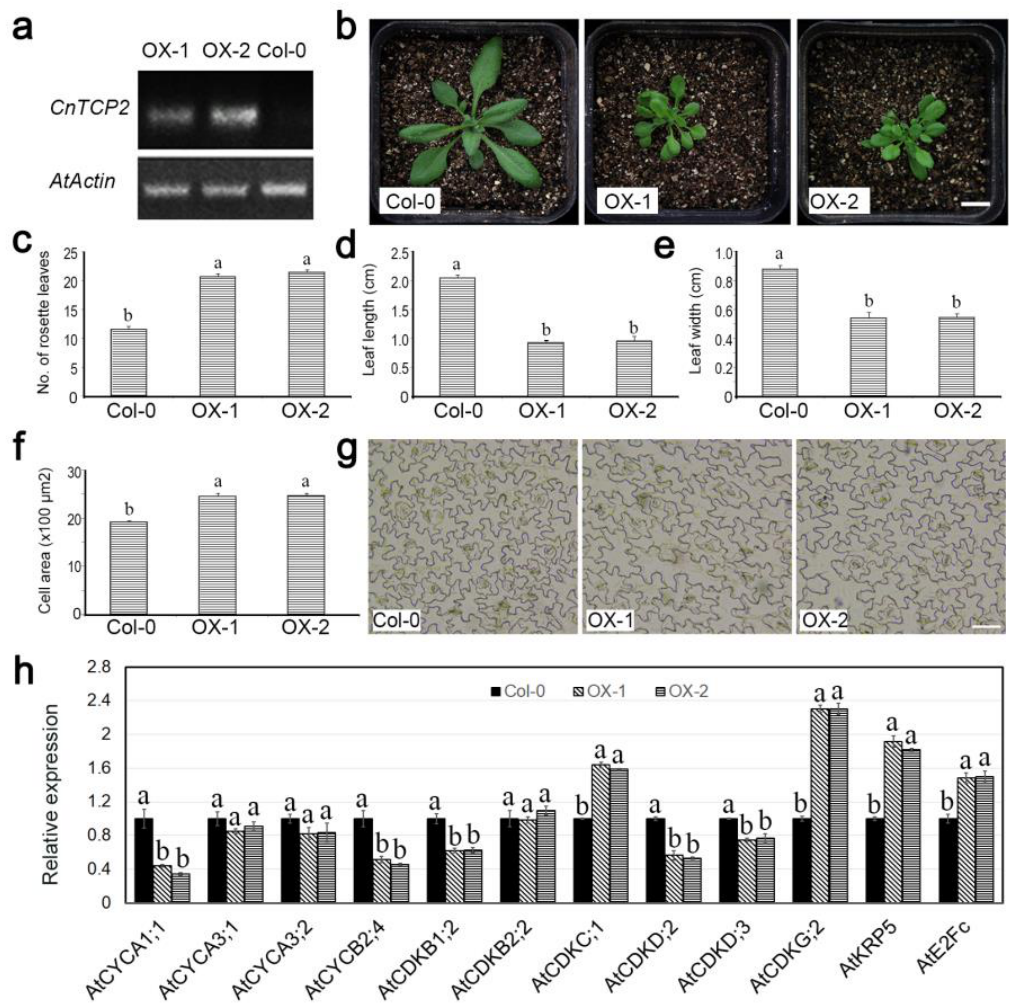
Figure 9. The phenotypic e ff ect of constitutively expressing CnTCP2 in A. thaliana . ( a ) RT-PCR-based identification of the transgenic A. thaliana plants OX-1 and OX-2. ( b ) The appearance of 35-day-old Col-0 wild type, and transgenic OX-1 and OX-2 plants. Bar: 1 cm. Quantification of leaf growth. ( c ) number of rosette leaves. ( d ) length of the fifth leaf. ( e ) width of the fifth leaf. ( f ) surface area of cells in the fifth leaf. Values in ( c ) through ( f ) shown as mean ± SE ( n = 10. ( g ) The appearance of epidermal cells sampled from the fifth leaf. Bar: 50 µ m. ( h ) The transcription of cell cycle marker genes. Col-0: wild type plants; OX-1, OX-2: transgenic plants. Values shown as mean ± SE (n = 3). Columns headed by a di ff erent letter denote transcript abundances di ff ering significantly ( p < 0.05) from the transcript abundance measured in Col-0